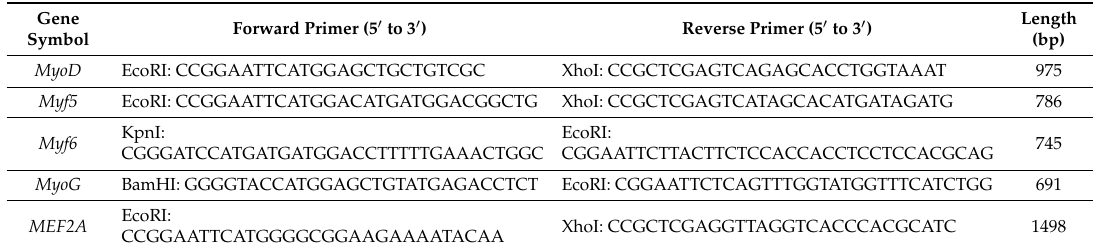
Table 6. Sequences of primers of coding sequence of MRFs family and myocyte-specific enhancer factor 2A ( MEF2A ) used for